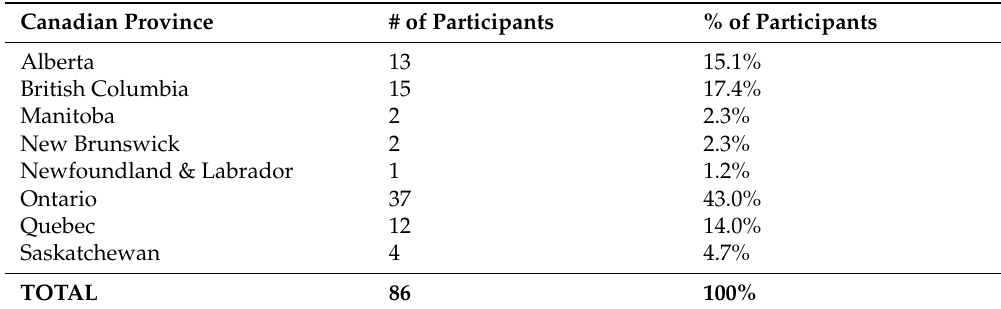
Table 5. Distribution of Canadian participants within the Global PWS Registry by province. Participants within the Registry represent eight of the Canadian provinces. Participants from Ontario make up the largest group of Canadian participants. Shown are the responses from those specifying a province; four Canadian participants did not answer this